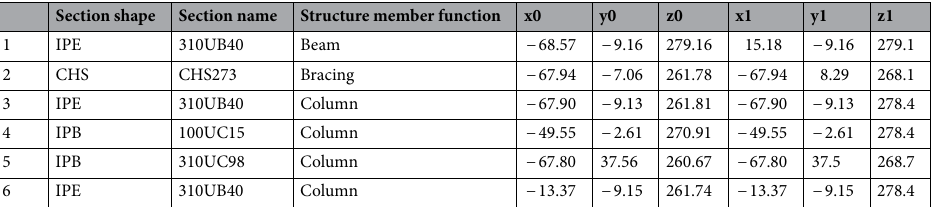
Table 2. Information obtained from structural members point